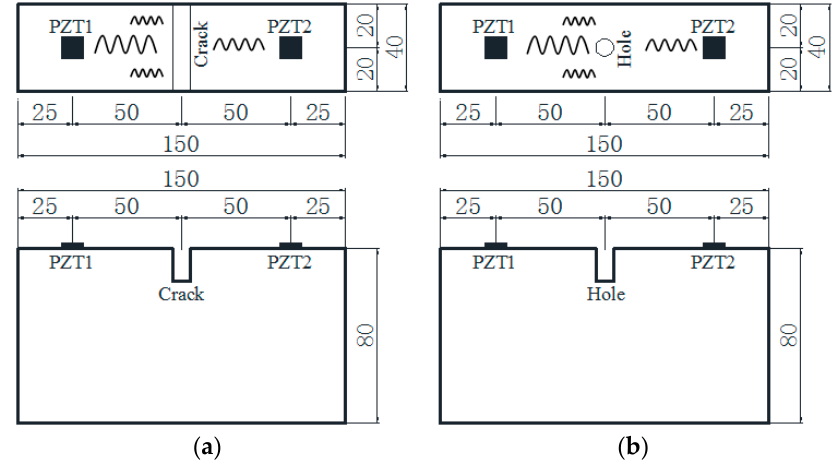
Figure 1. Stress-wave-based active sensing approach for timber damage detection (unit: mm). ( a ) Timber damage with a crack; ( b ) timber damage with a hole.